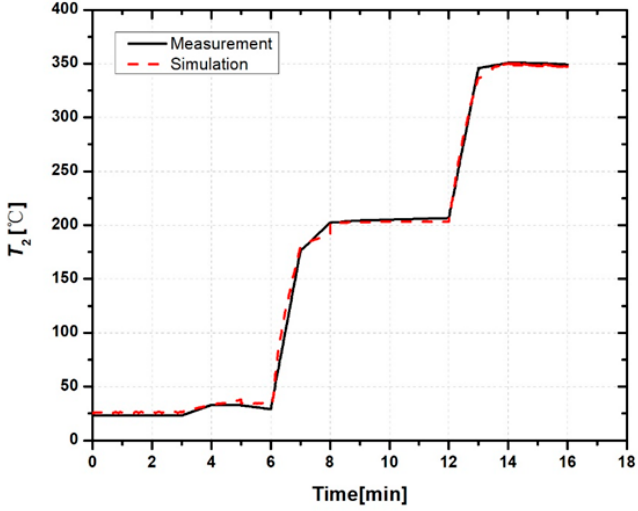
Figure 8. Comparison of simulation results and measuring data for compressor discharge temperature.